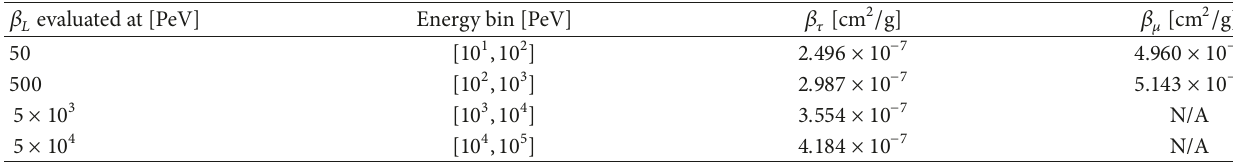
Table 3: Numerical values of 𝛽 𝐿 calculated with the ASW structure functions from [10] for 𝜏 ’s and from the results obtained by [11] for 𝜇 ’s. The table presents the energy at which the parameter was evaluated and the energy bin in which it is used in the numerical calculations. 𝛽 𝐿 evaluated at [PeV]